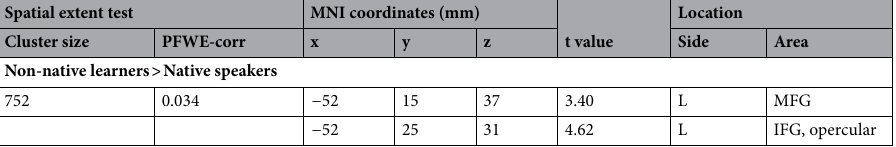
Table 3. Regions associated with more grammar processing in non-native learners or native speakers. Activation was set at a threshold value of p < 0.05 and FWE was corrected for multiple comparisons over the whole brain, with the height threshold set at p < 0.001, uncorrected. The terms x, y, and z represent the stereotaxic coordinates (mm). R, right hemisphere; L, left hemisphere; IFG, inferior frontal gyrus; MFG, middle frontal gyrus; MNI, Montreal Neurological